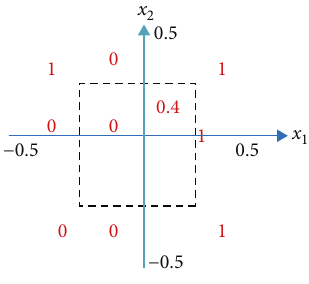
Figure 5: Third generation of f